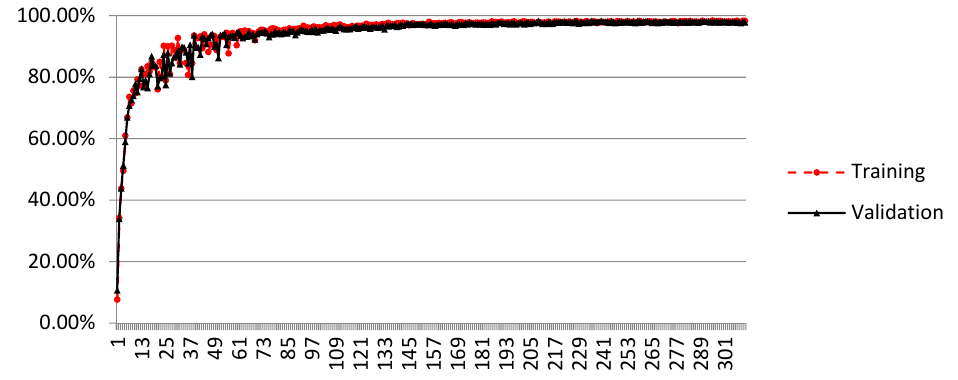
Figure 11. Training process of dataset A. Table 5. Detection results of dataset A.